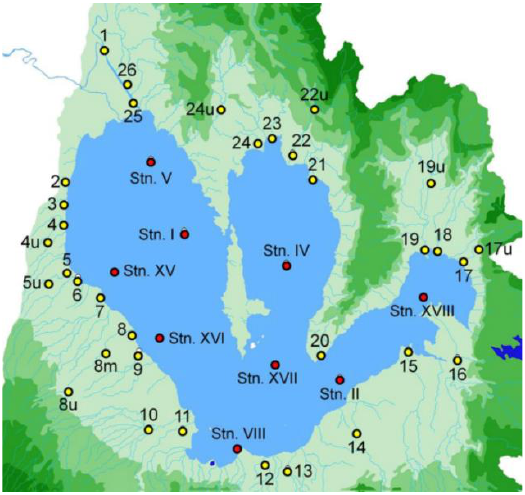
Figure 1. Water quality monitoring stations in Laguna Lake and its tributaries (Source: